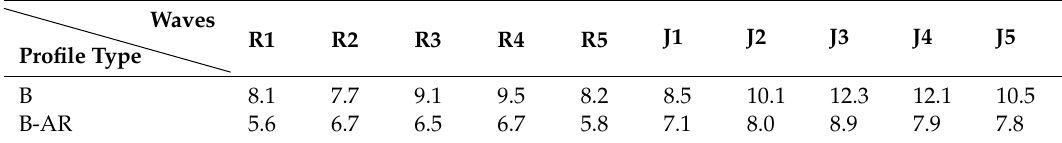
Table 6. The surf-scaling parameter ( ε ) of all tests.